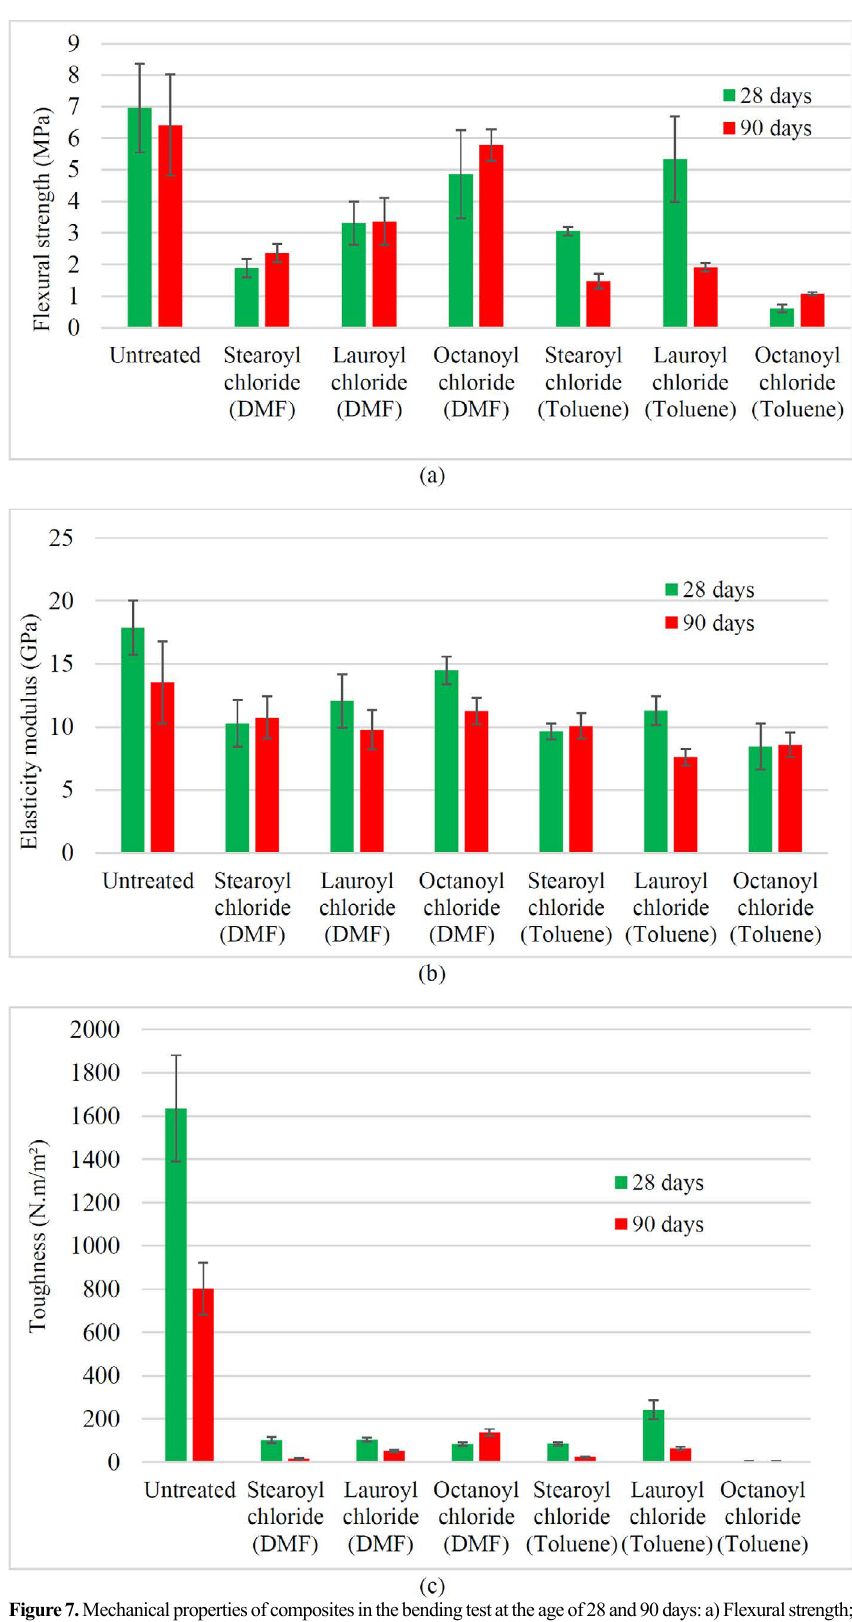
Figure 7. Mechanical properties of composites in the bending test at the age of 28 and 90 days: a) Flexural strength; b) Elasticity modulus; c)